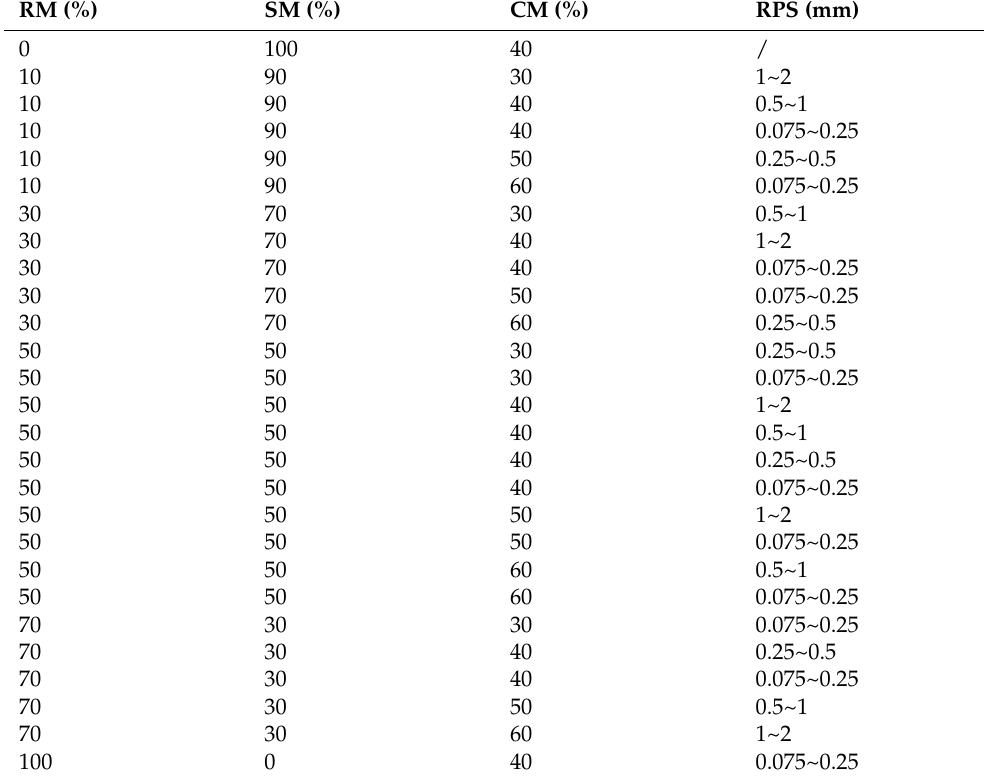
Table 2. Mix proportions of the rubber-concrete